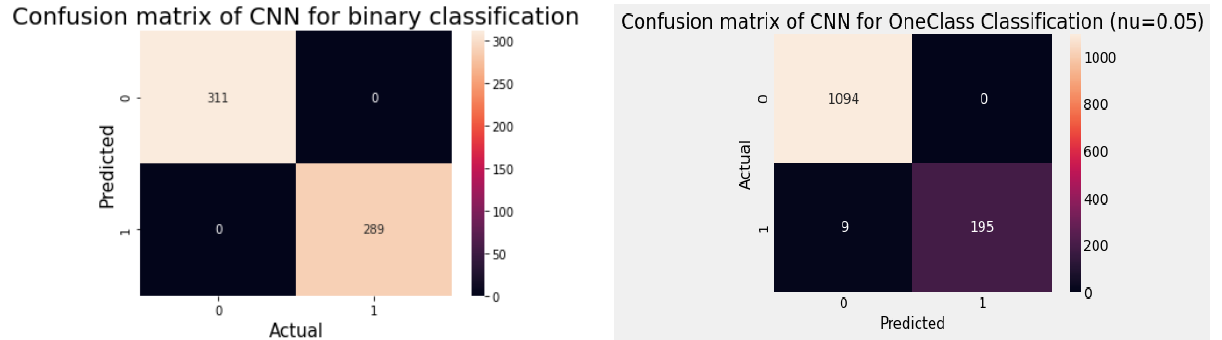
Figure 14. Confusion matrices for both tasks (left matrix — binary classification, right matrix — one- class classification).